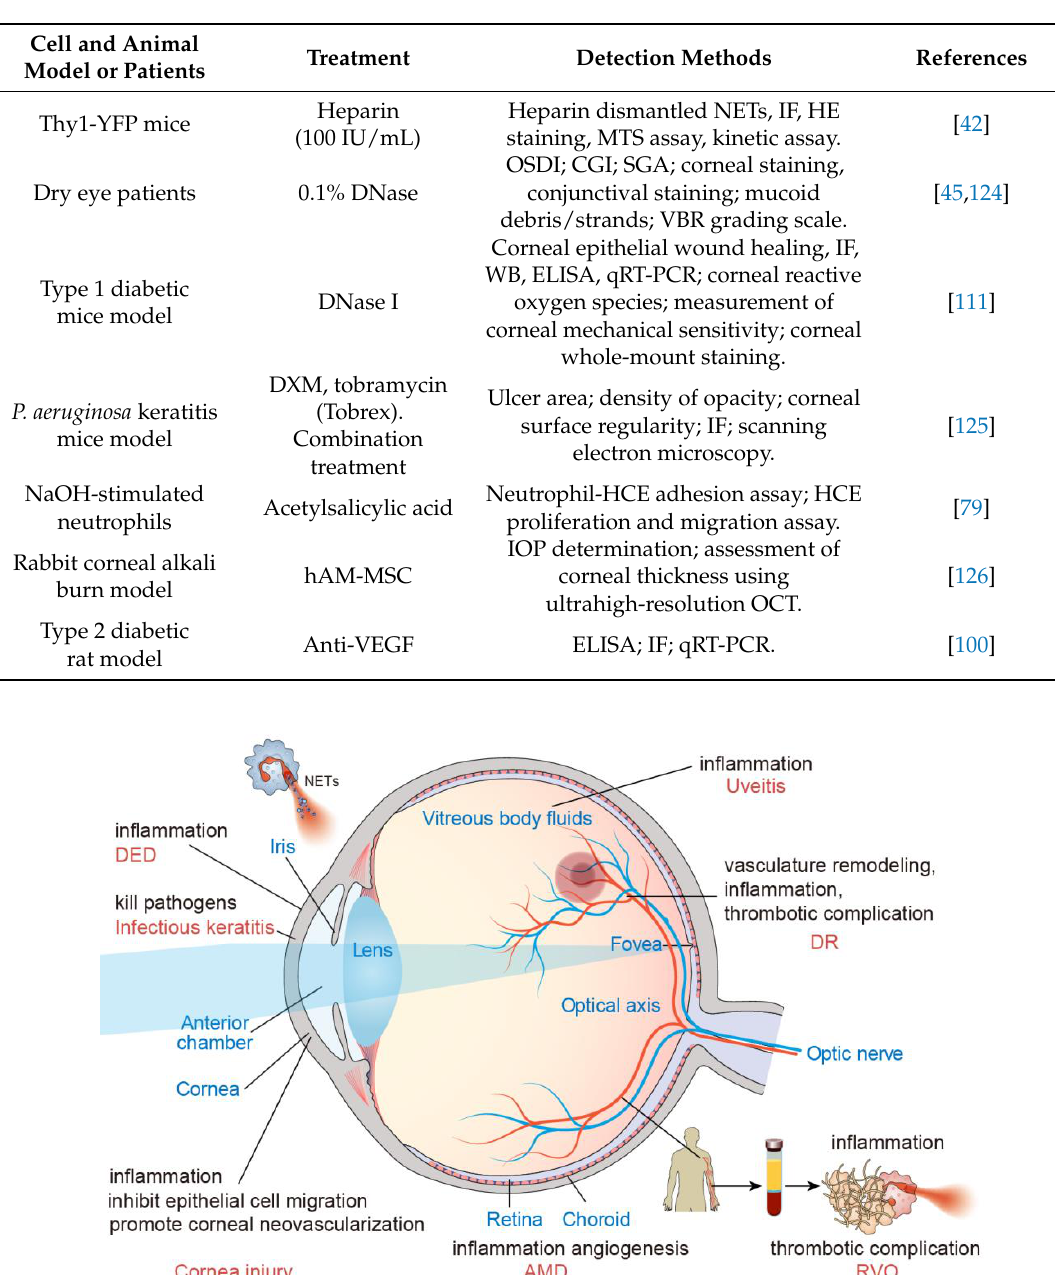
Table 1. The interference of NETs in ocular diseases.